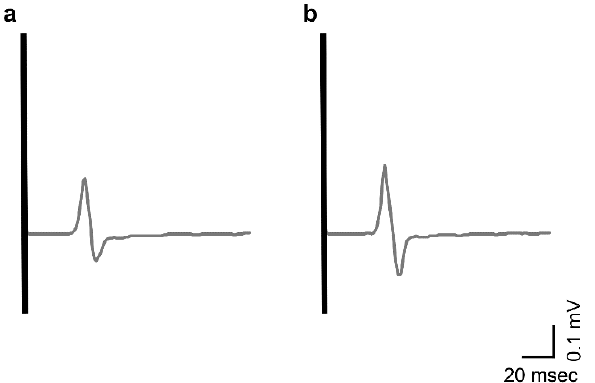
Figure 2. Typical MEP waveforms pre- and post-PES as recorded from a representative participant. The MEP amplitude was lower ( a ) pre-PES than ( b ) post-PES. MEP, motor-evoked potential; PES, peripheral sensory nerve electrical